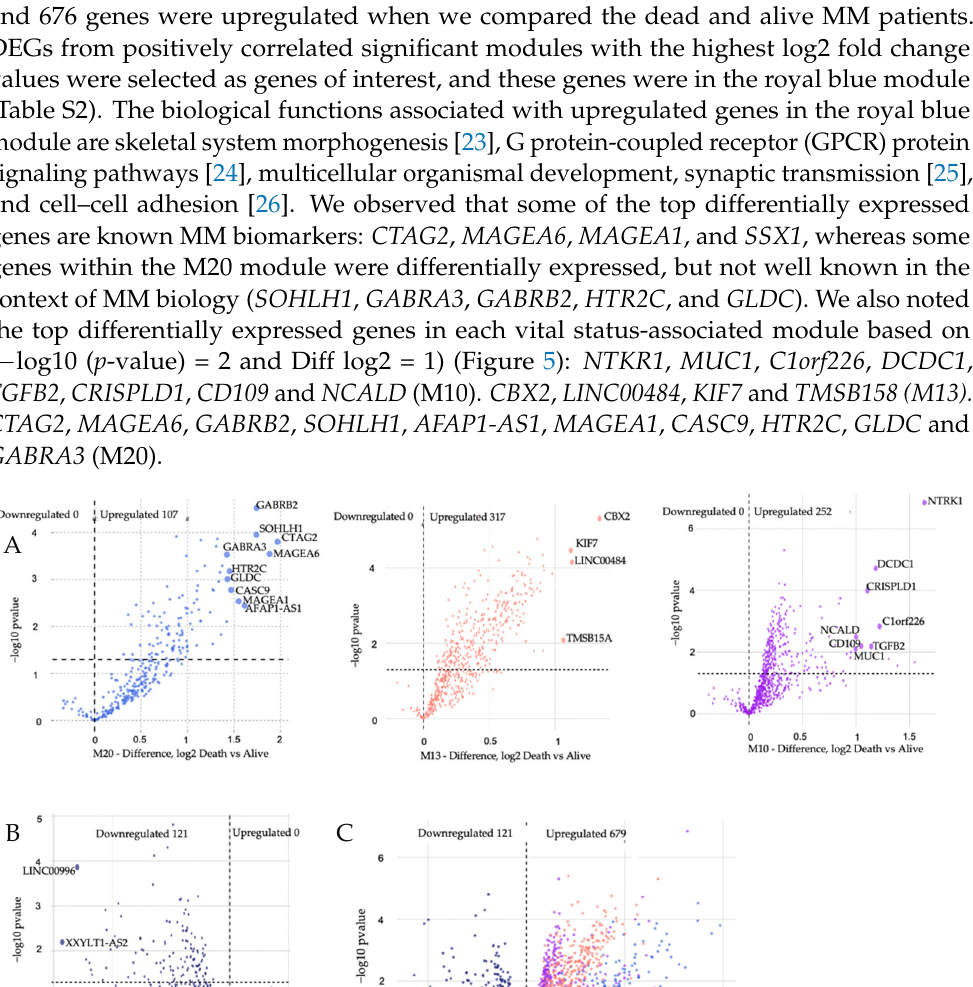
Figure 4. Box plots of differential expression patterns of module eigengenes across MM patient sam- ples. Each color of the box represents the module and the associated p- values. Royalblue, salmon, and purple modules are positively correlated with vital status of MM patients on standard RVD therapy. However, the midnight blue module is negatively correlated with MM vital status. The small circles in the figure depict the outliers in the data.